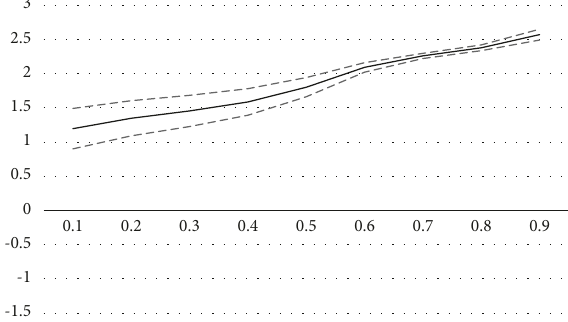
Figure 4: Industry-EPU quantile regression result.